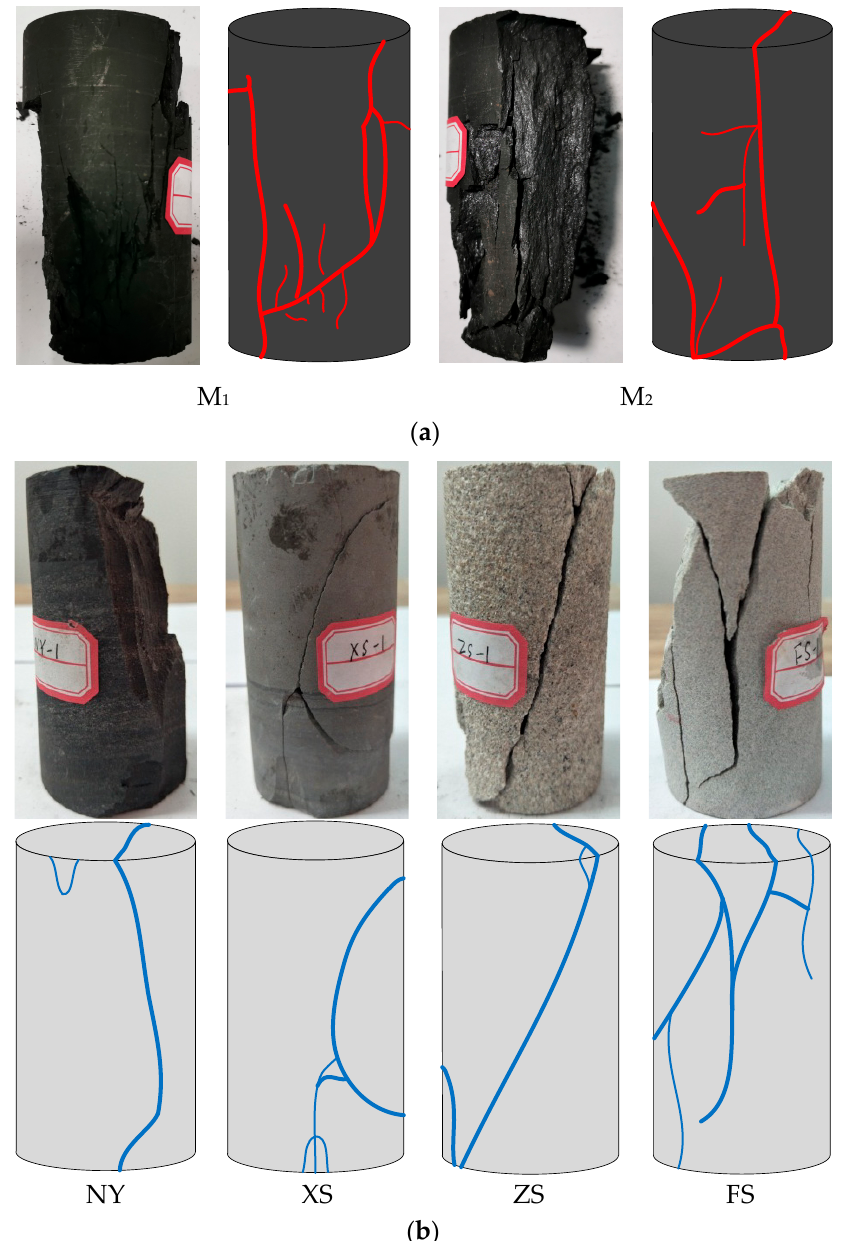
Figure 7. The typical failure modes of pure coal/rock: ( a ) The pure coal specimens; ( b ) The pure rock specimens